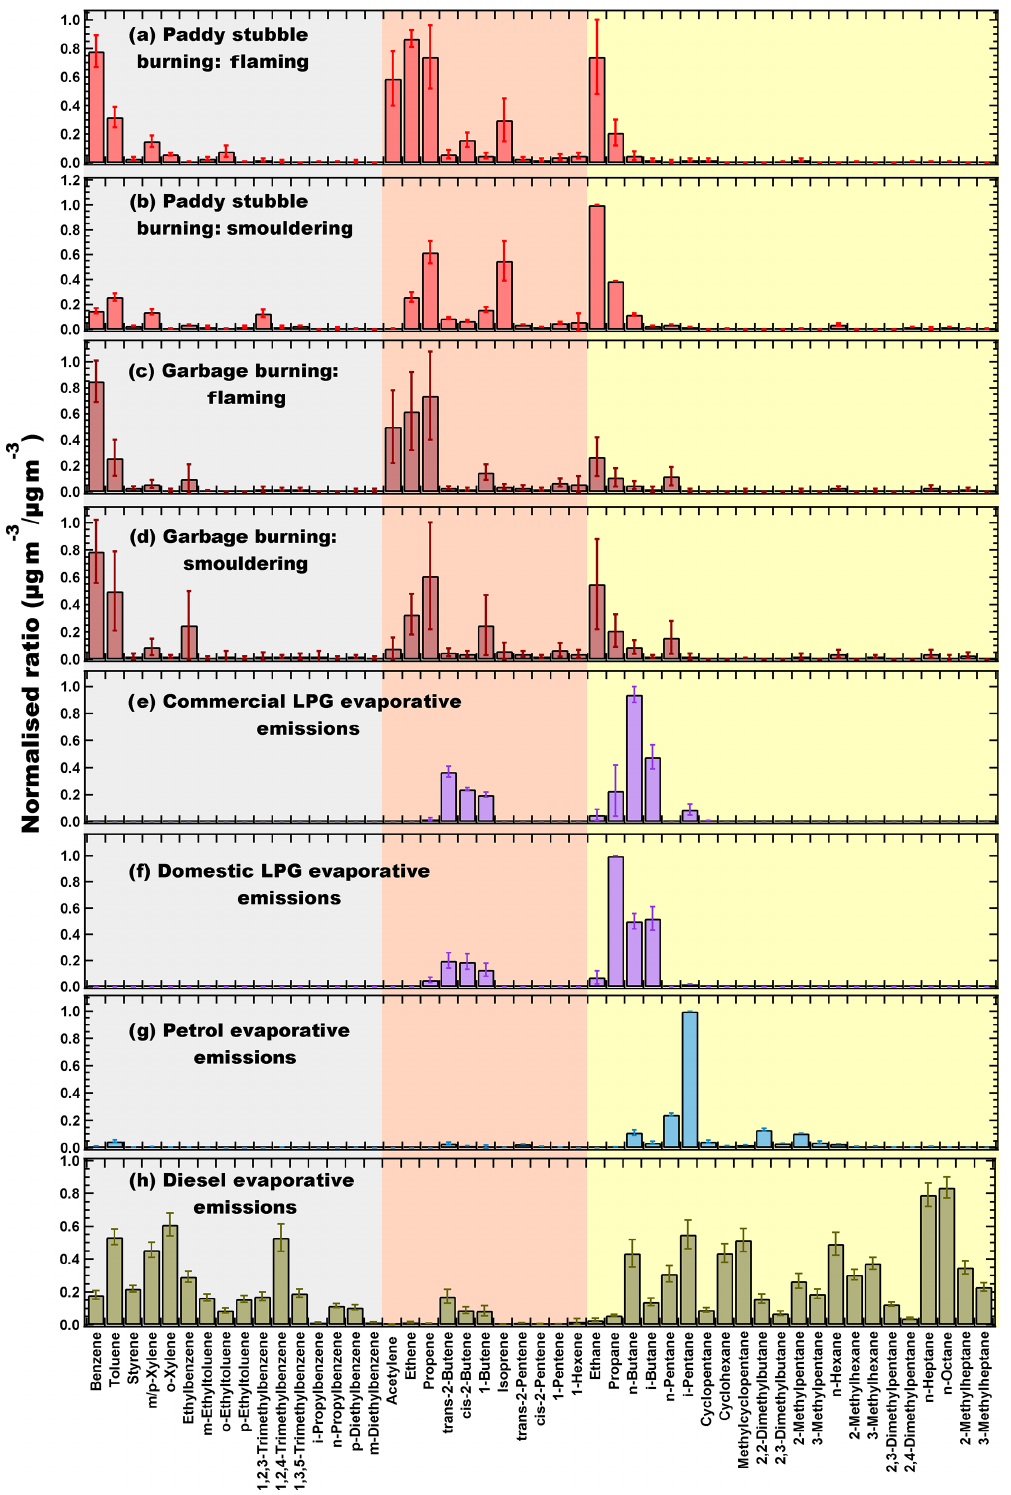
Figure 1. Normalised source profiles of (a) paddy stubble burning – flaming. (b) Paddy stubble burning – smouldering. (c) Garbage burning – flaming. (d) Garbage burning – smouldering. (e) Commercial liquefied petroleum gas (LPG) evaporative emissions. (f) Domestic LPG evaporative emissions. (g) Petrol evaporative emissions. (h) Diesel evaporative emissions derived from the thermal desorption gas chro- matography flame ionisation detection (TD-GC-FID) measurements. Error bars represent the standard error of averaged normalised ratio. Grey highlights the aromatics, red the alkenes and alkyne and yellow the